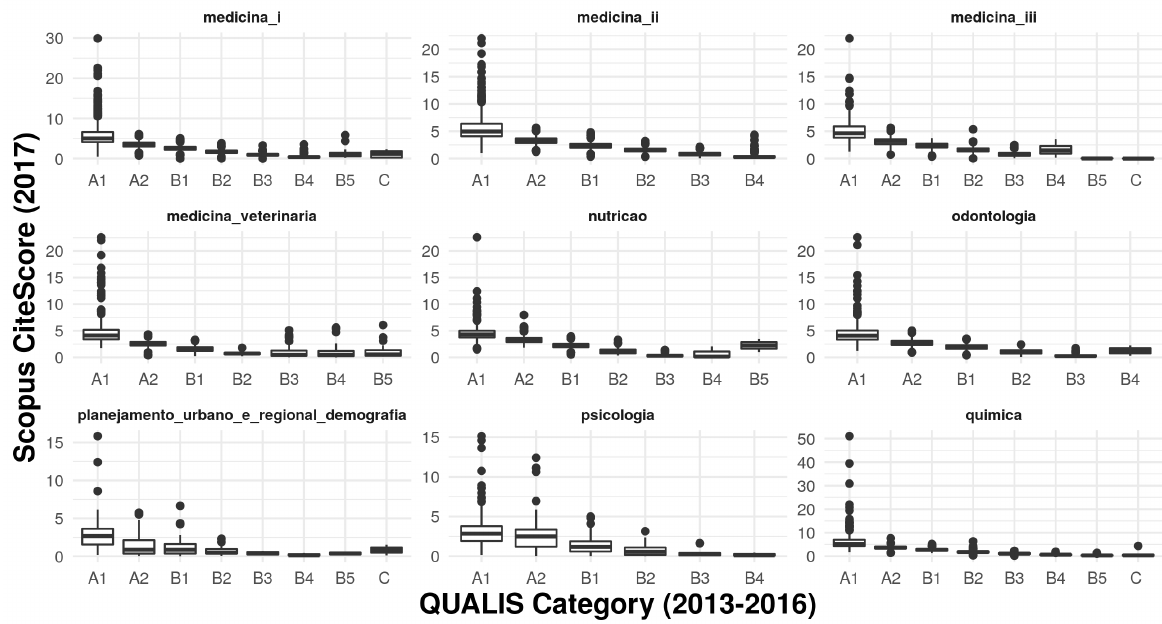
Figure 7. Scopus CiteScore variation across QUALIS categories in nine subject area. Original QUALIS subject area names are shown (as written in their respective classification sheets) but their English translation can be found in Table SI.